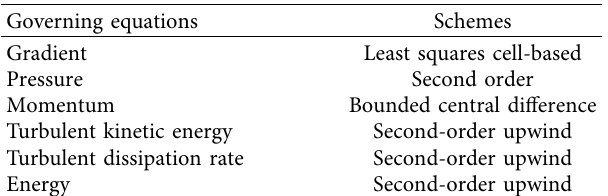
Table 2: Spatial discretization schemes for the governing equations.